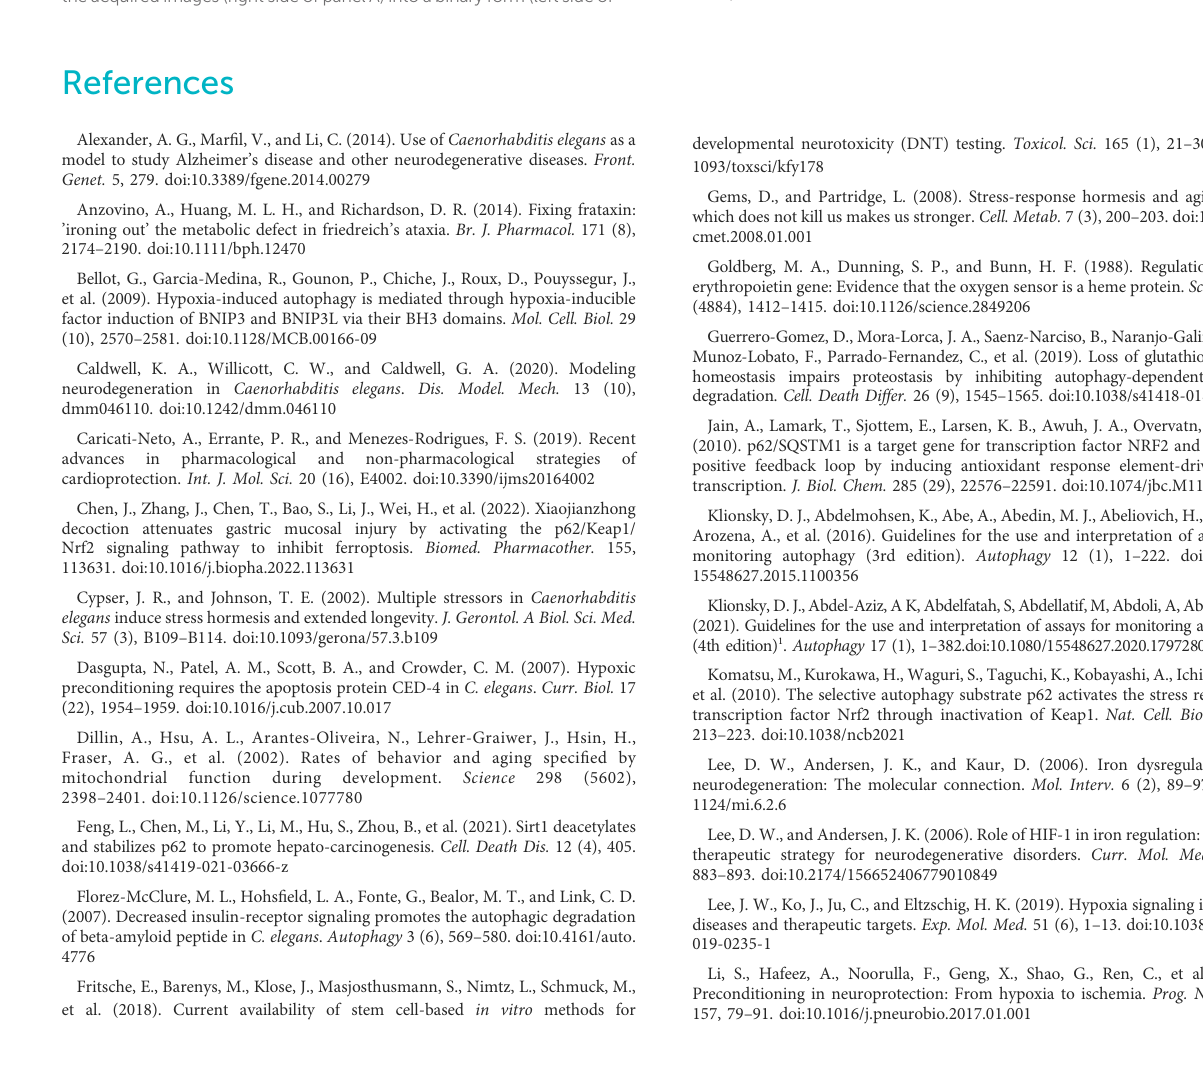
panel A). (B) Bar graph represents means ± SD ( n = 3, N=10 – 15). Comparison between untreated and CoCl 2 at the same time point was performed using the unpaired t-test. * p value < 0.05 and **** p value < 0.0001. Scale bar = 100 µm. SUPPLEMENTARY FIGURE S2 Developmental rate of wild-type (WT) and hif-1 KO animals from eggs through four different larval stages, until young (YA) and gravid (GA) adults, either left untreated ( − ) or treated from eggs with 500 µM CoCl 2 (+) and followed for 5 days after hatching at 20 ° C. SUPPLEMENTARY FIGURE S3 (A – D) Western blot analysis of LC3II (A) , p62 (B) , COXII (C) , and COXIV (D) proteins extracted from HeLa cells left untreated ( − ) or treated (+) with 250 µM alone or in combination with 1mM of CoCl 2 at different time points (4, 16, and 24 hours). Proteins were normalized using vinculin. Representative Western blots are shown. Bar graph represents means ± SD (N = 3). Comparison between groups was performed using the unpaired t-test. * p value < 0.05. SUPPLEMENTARY FIGURE S4 Representative pictures of HeLa cells left untreated ( − ) or treated (+) with 250 µM alone or in combination with 1 mM of CoCl 2 (+) at different time points (4, 16, and 24 hours). White squares represent the magni fi ed crop (2x) shown on the right. Scale bar = 100